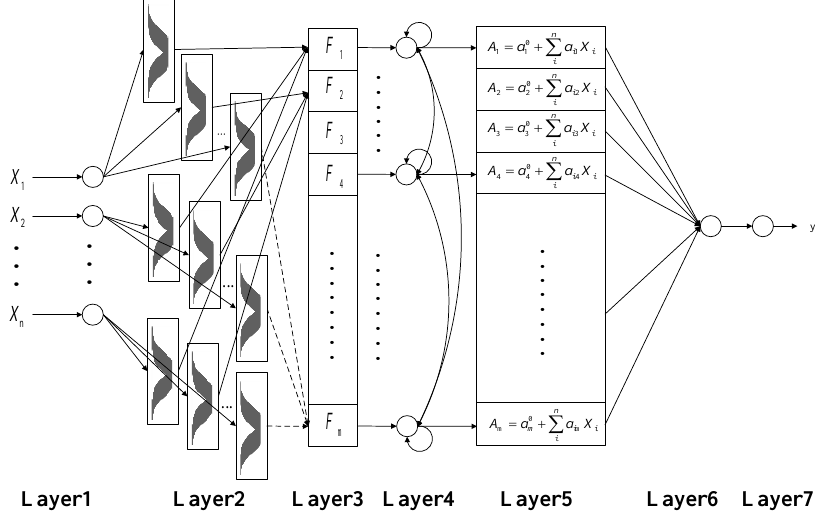
Figure 7. Structure of T2FCMAC classifier.